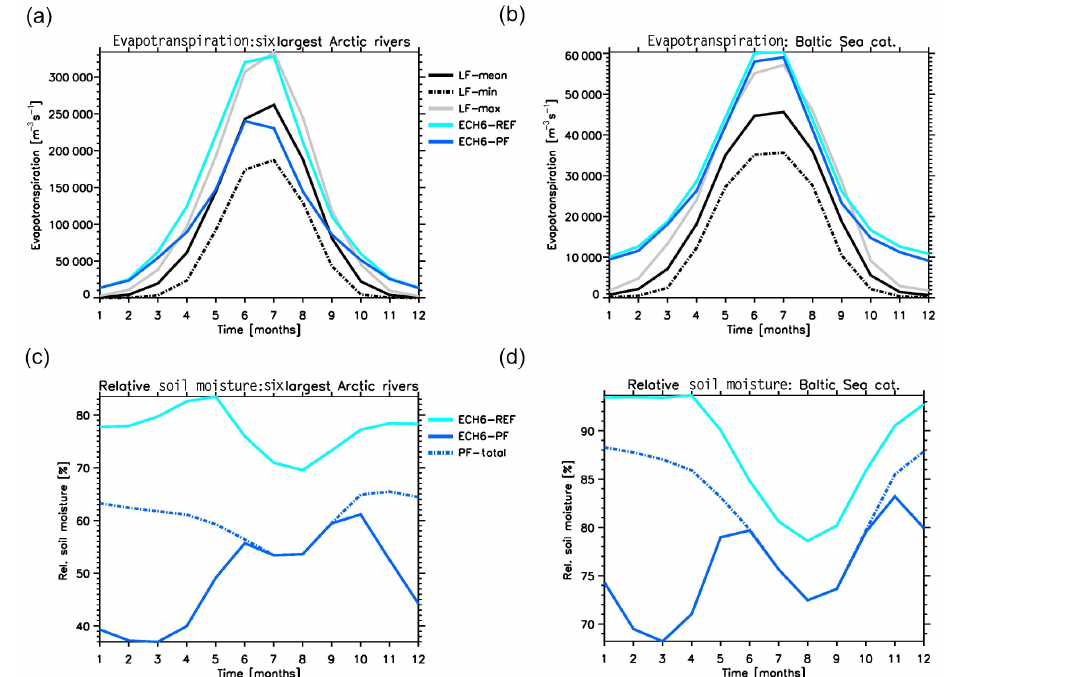
Figure 6. Mean monthly climatology (1989–2009) of evapotranspiration (upper panels) and relative root zone soil moisture (lower panels) over the six largest Arctic river catchments (left column) and the Baltic Sea catchment (land only, right column). Evapotranspiration data comprise the mean, minimum, and maximum diagnostic estimates from the LandFlux Eval (LF) dataset. The dashed blue line (PF-total) denotes the total root zone moisture content (liquid + frozen) for ECH6-PF.